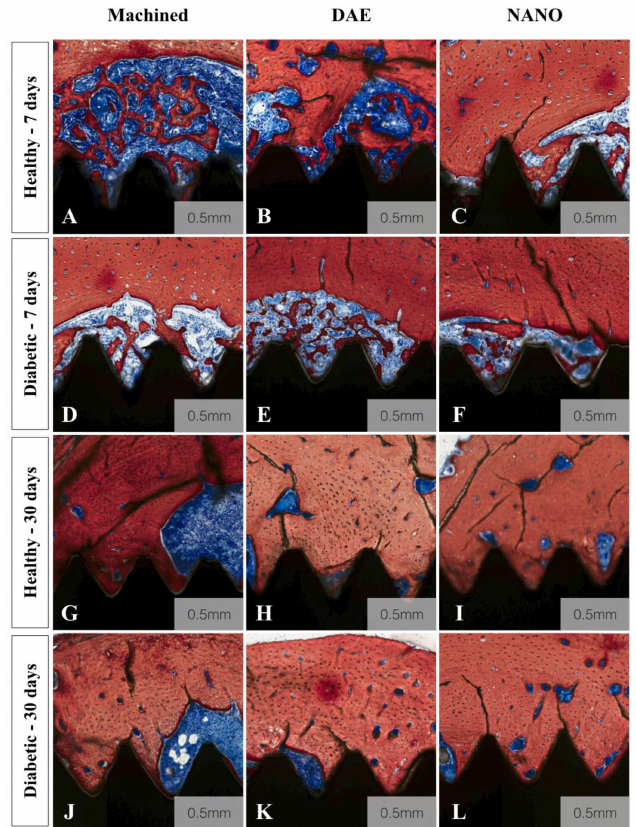
Figure 3. Histologic micrographs of all experimental groups ( A – L ). Stevenel’s blue Alizarin